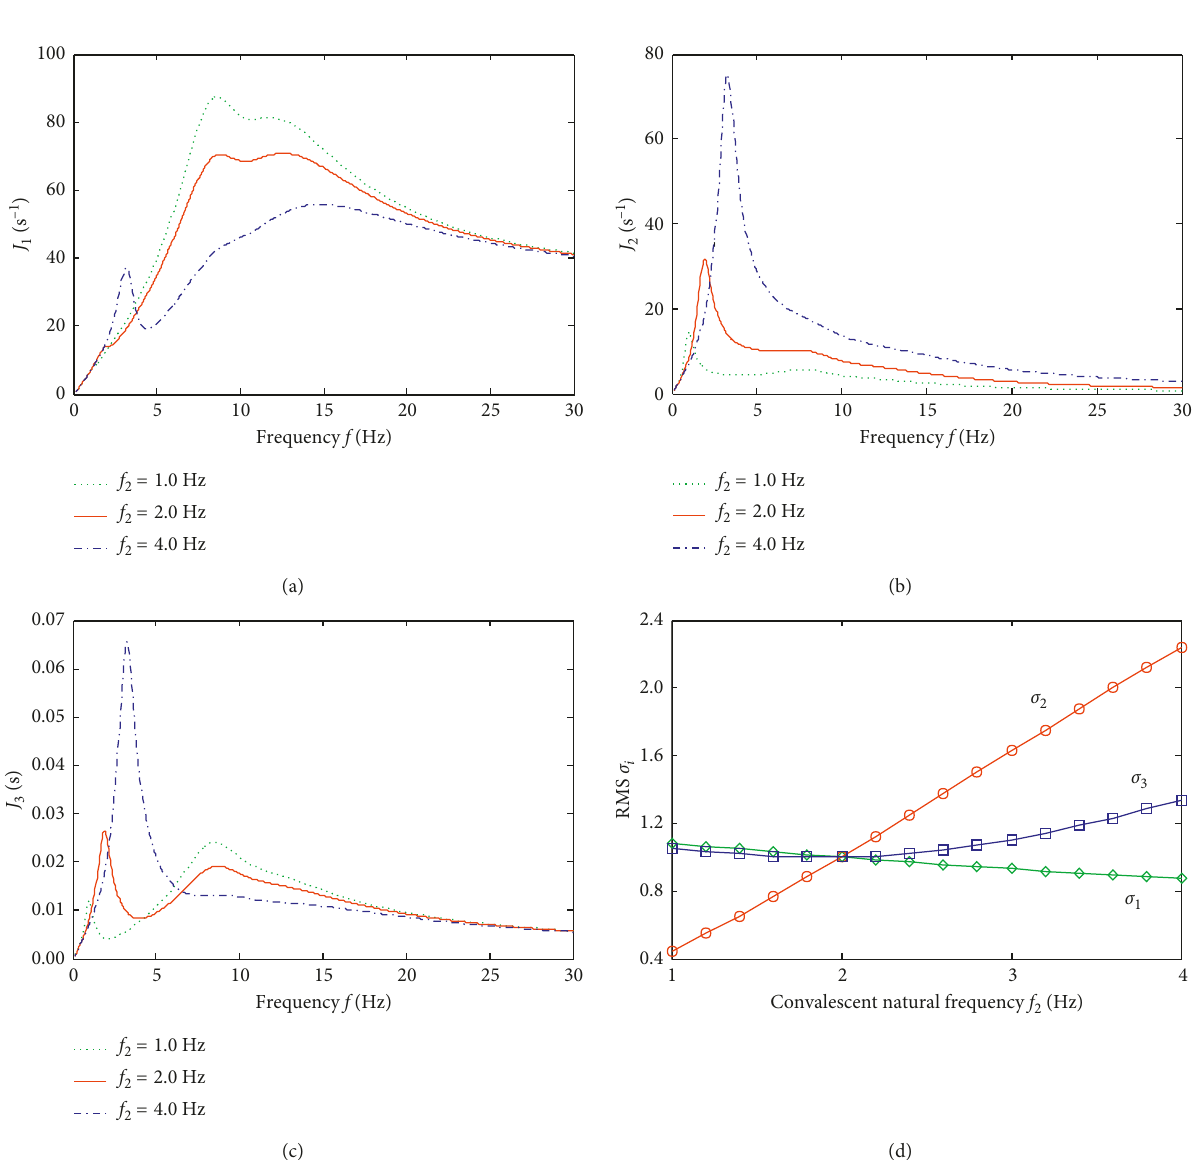
at different values of f 1 at different values of f 3